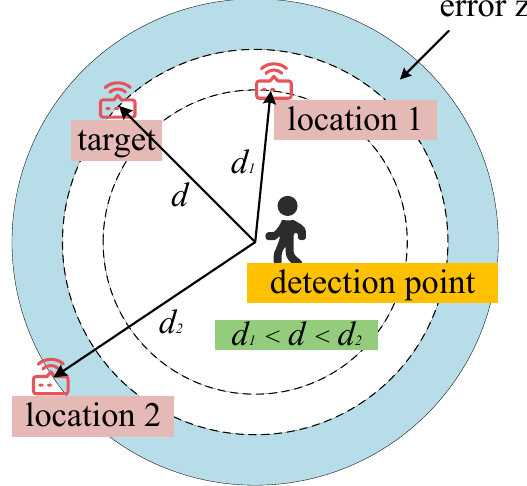
Figure 6. The region where the target node is.